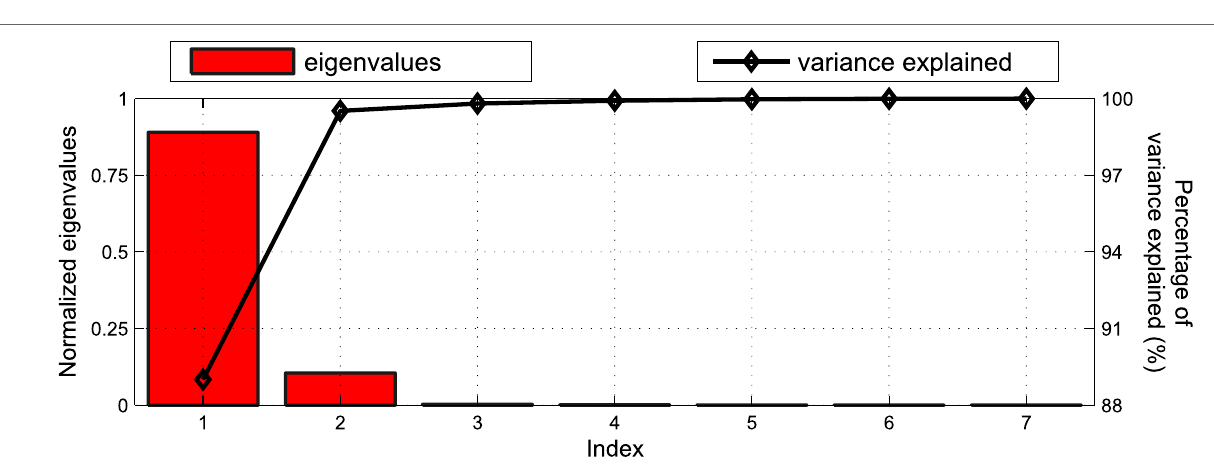
FIGURE 6 | Normalized eigenvalues and percentage of explained variance of the estimation set